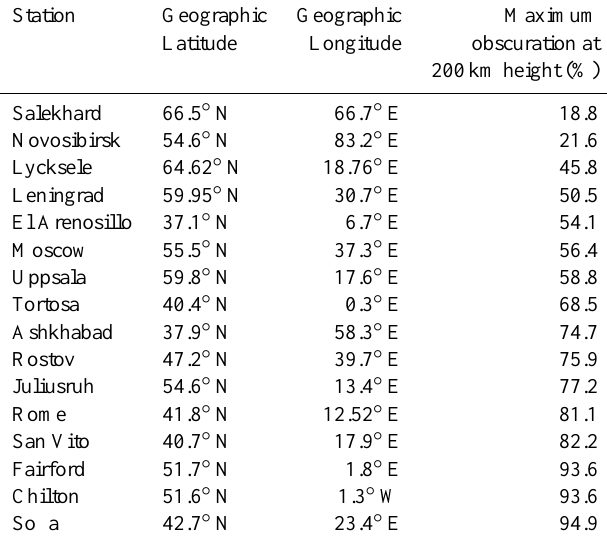
Table 1. Locations of the ionosonde stations used during the eclipse measurements and their maximum solar obscuration at 200km